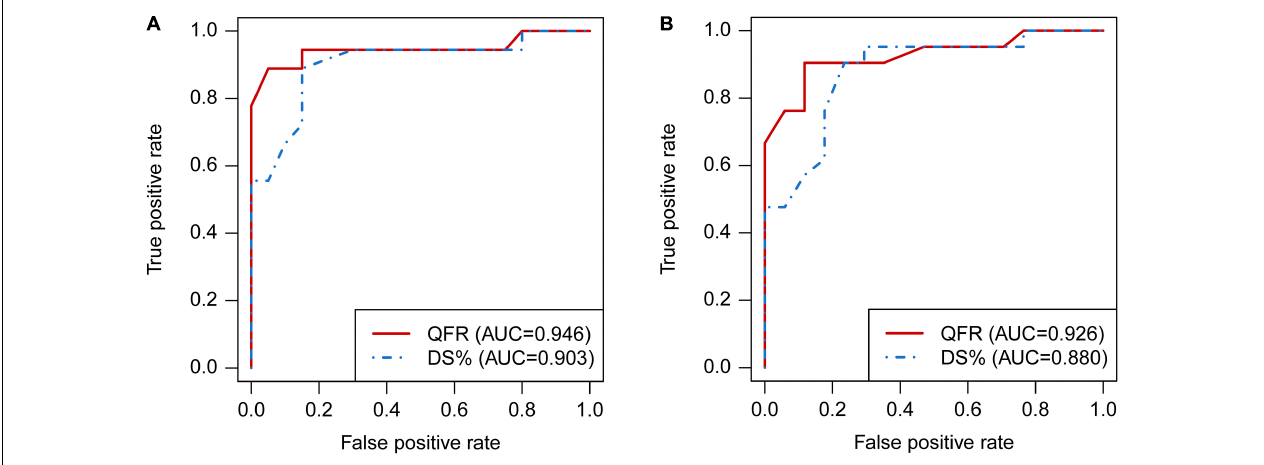
FIGURE 4 | Comparison of diagnostic performance between QFR and DS% by receiver operating characteristic (ROC) analyses. The ROC curves of QFR and DS% in predicting FPR < 0.70 (A) and FPR < 0.75 (B) , respectively. QFR, quantitative flow ratio; DS, diameter stenosis; ROC, receiver operating characteristic; FPR, fractional pressure ratio. TABLE 3 | The diagnostic performance of dichotomous QFR and DS% in predicting hemodynamically significant lesions. Predicting FPR <